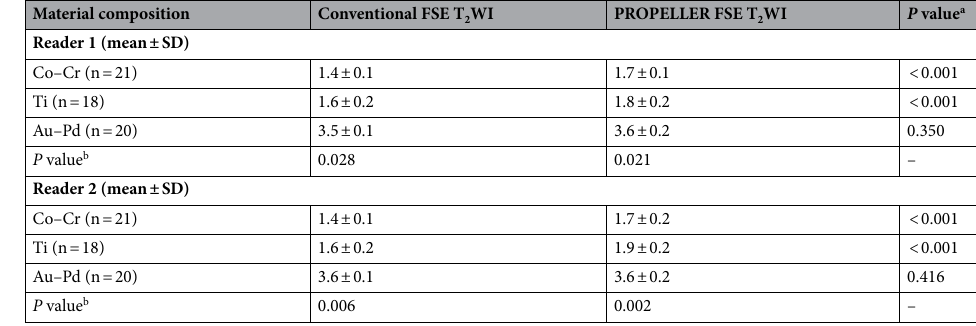
Table 2. Comparison of image quality scores of different metal crowns in conventional FSE T 2 WI and PROPELLER FSE T 2 WI sequences. FSE T 2 WI, fast spin echo T 2 weighted imaging; PROPELLER FSE T 2 WI, periodically rotated overlapping parallel lines with enhanced reconstruction fast spin echo T 2 weighted imaging; Co–Cr, cobalt-chromium; Ti, titanium; Au–Pd, gold–palladium. a Two-sample Wilcoxon test. Significant P -values were < 0.05. b Friedman test. Significant P -values were < 0.05.